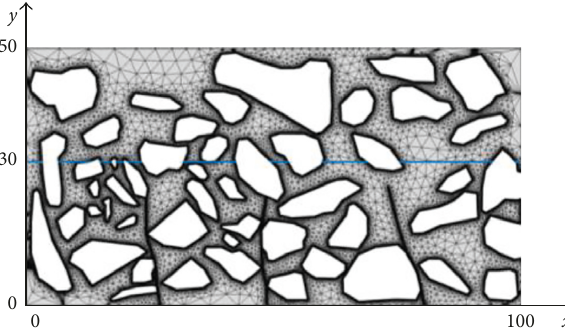
Figure 13: Calculation line for average chloride